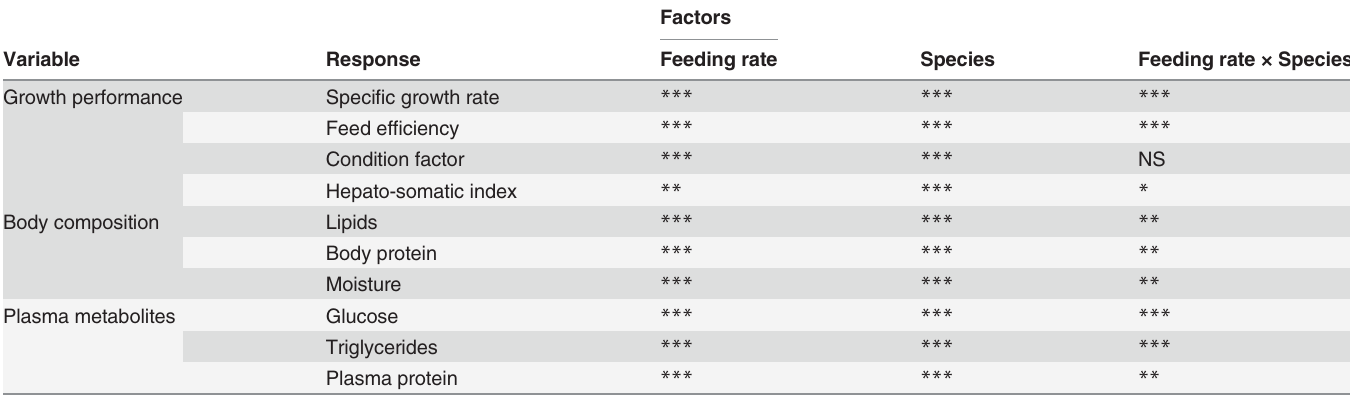
Table 1. Significance levels of main effects and interactions for feeding rate and species on biological